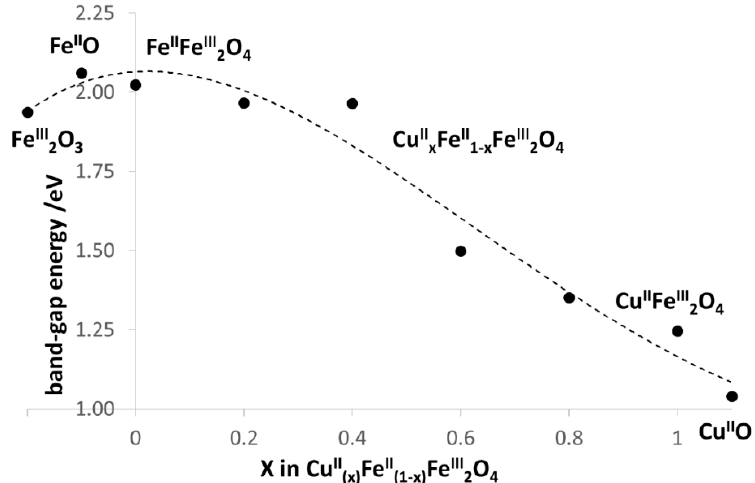
Figure 6. Band-gap energies (E bg ) of doped NPs as the function of Cu 2+ content for comparison to those of the simple metal oxides.